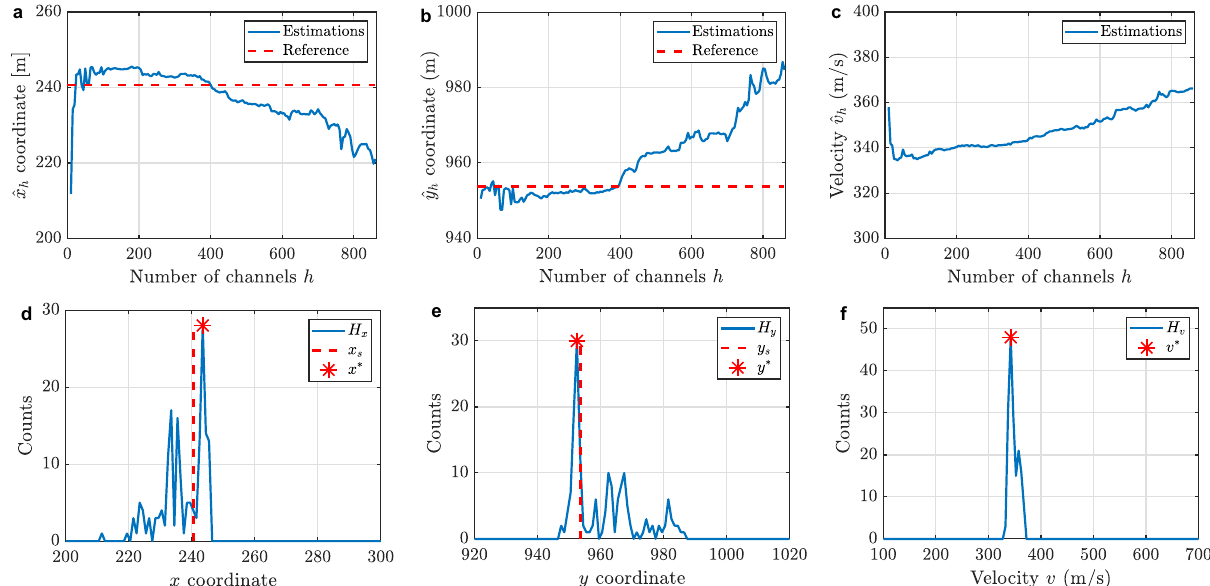
Fig. 7 Source location estimation using different number of sensors h . Estimated a ^ x h coordinate, b ^ y h coordinate, and c average propagation velocity ^ v h , as a function of the number of channels h used in the process. The histogram of each estimated parameter uses a bin width of 1 m for the histogram d H x and e H y , and a bin of 5 m s − 1 for the histogram f H v . Dashed red lines correspond to the actual source coordinates x blindly selected coordinates and velocity based on the mode of the histograms.